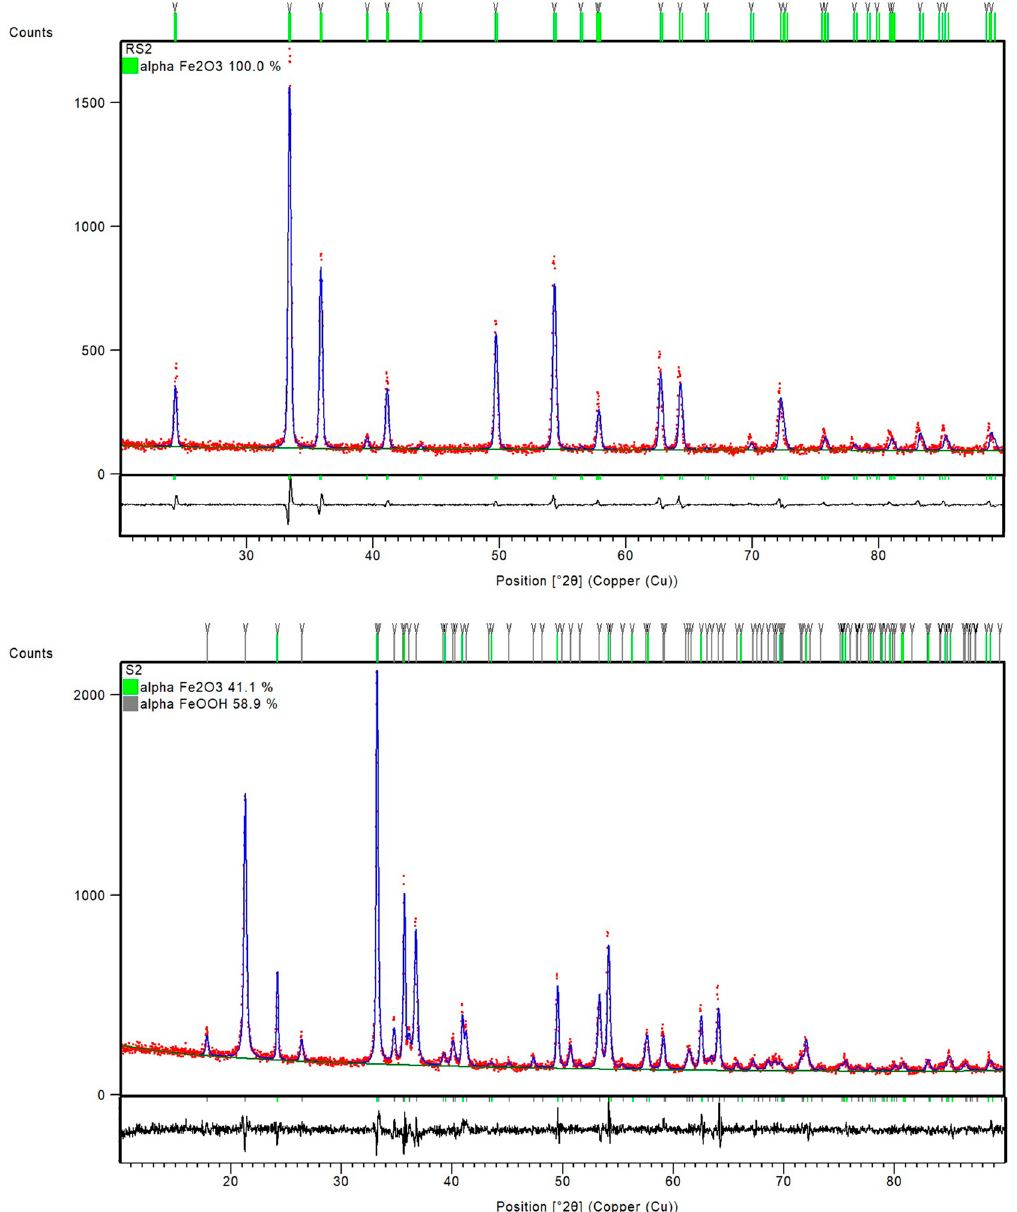
Figure 3. Final observed (red dots) and calculated (blue, solid lines) powder diffraction profiles for reference sample RS2 and sample S2 as obtained from the Rietveld refinement. The green and gray tick marks show the reflection positions of α -Fe 2 O 3 and α -FeOOH, respectively. The lower, black, solid lines show the difference profiles.